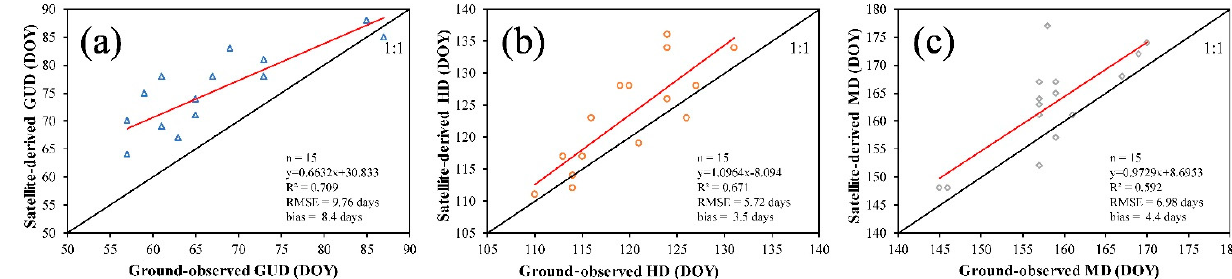
Figure 8. The spatial distribution of winter-wheat phenological phases for ( a ) GUD, ( b ) HD, and ( c ) MD, and frequency distributions for ( d ) GUD, ( e ) HD, and ( f ) MD.